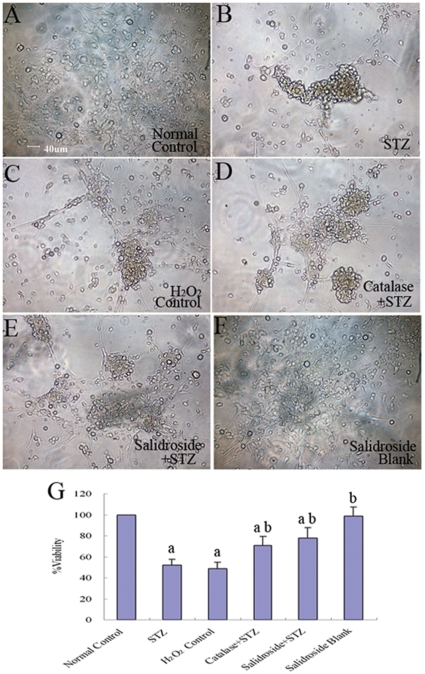
Cell morphology (A–F) and cell viability as measured by the MTT assay (G).NSCs at the second passage were seeded on poly-L-lysine-coated culture plates and grouped for the following treatments: (A) Normal control group without any treatment; (B) STZ group treated with STZ for four hours; (C) H2O2 control group treated with H2O2 for four hours; (D) Catalase+STZ group treated with catalase for twelve hours followed by four-hour incubation with STZ; (E) Salidroside+STZ group treated with salidroside for twelve hours followed by four-hour incubation with STZ; (F) Salidroside blank group treated with salidroside for twelve hours. Values are expressed as mean±SD. a
p<0.05 compared with the normal control group; b
p<0.05 compared with the STZ group.